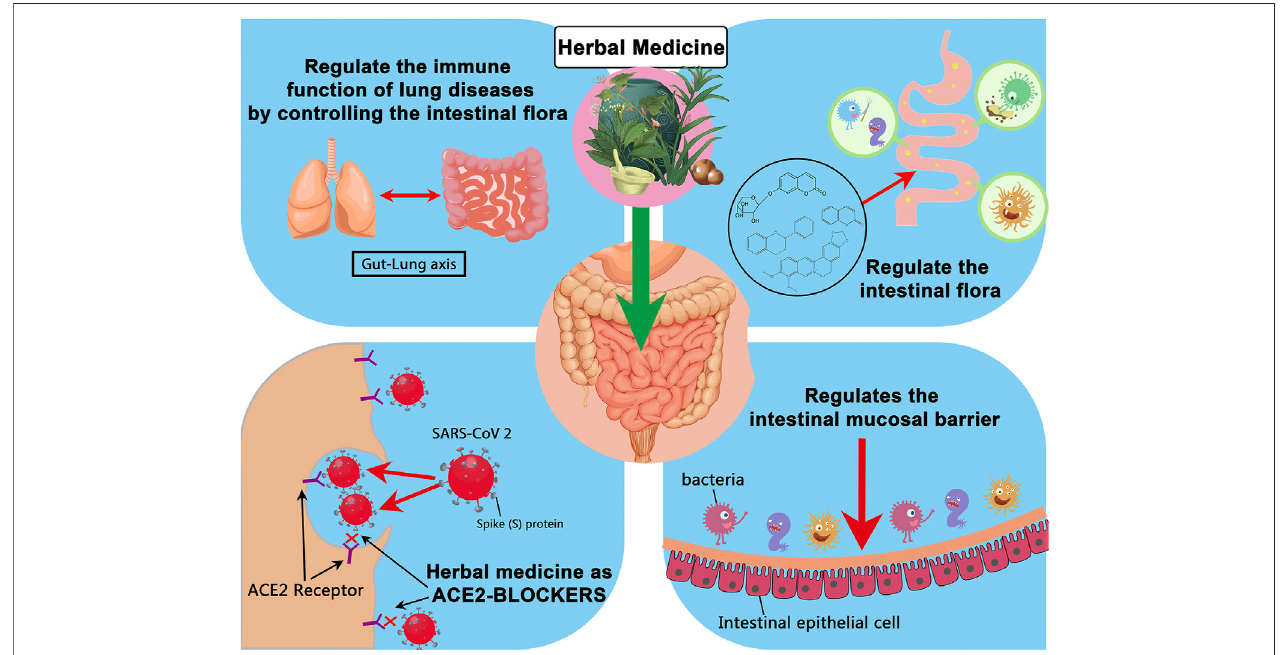
FIGURE 4 | Summary of possible ways in which herbal medicines can affect the prognosis of COVID-19 by regulating the intestinal fl ora.